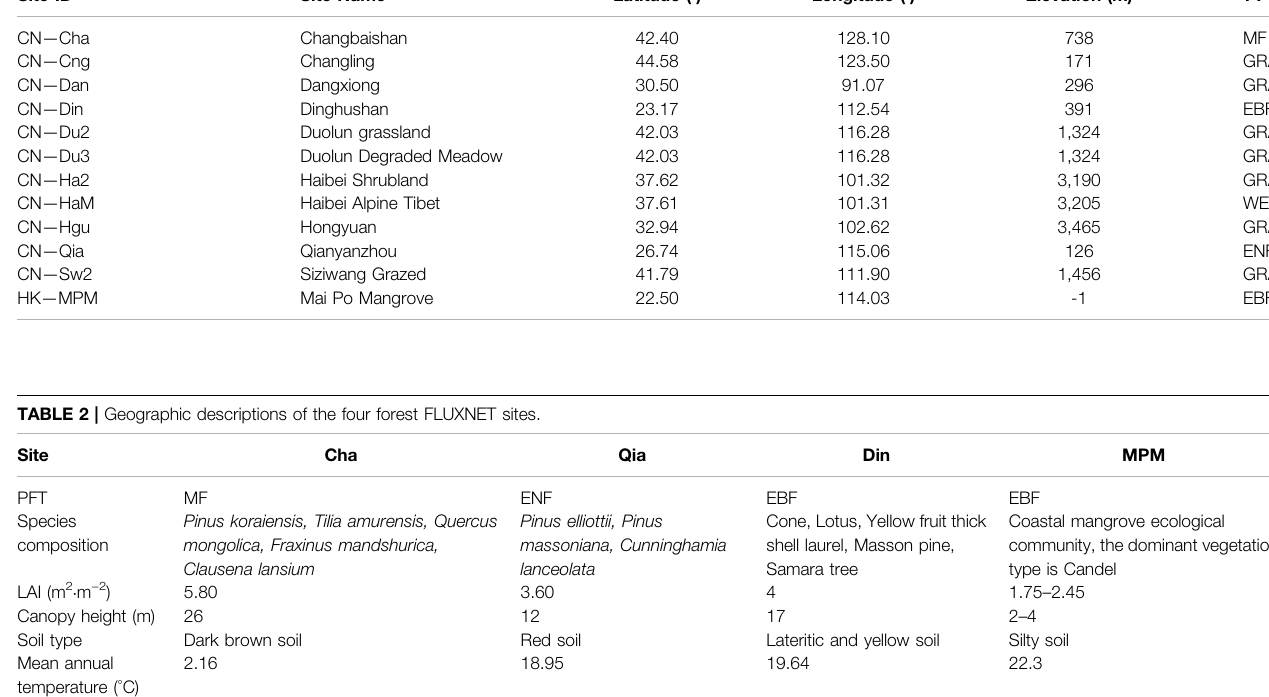
TABLE 1 | The overview of the 12 FLUXNET sites in China. Site ID